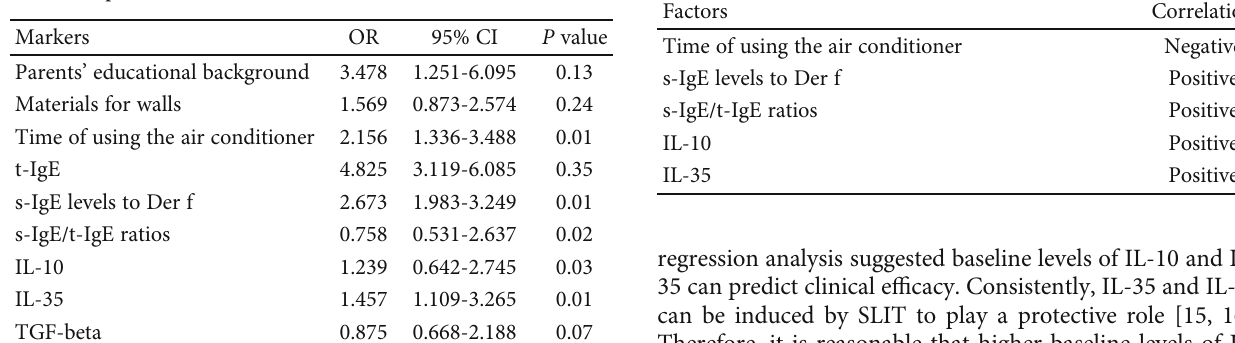
Table 6: Multivariate logistic analysis of factors associated with clinical response to SLIT.